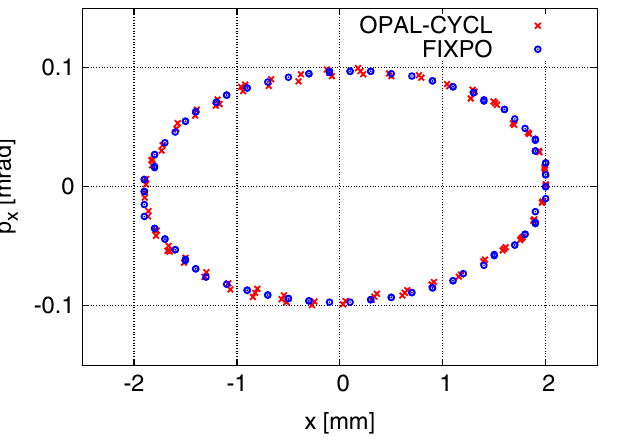
FIG. 6. (Color) The time consumption as a function of process- ors on Cray XT3, CSCS.